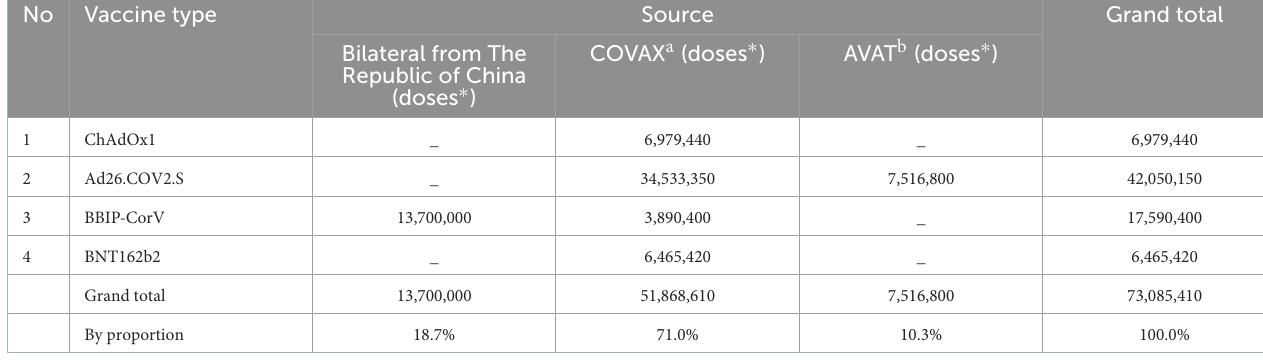
TABLE 1 The sources, types and number of doses of COVID-19 vaccines received in Ethiopia as of